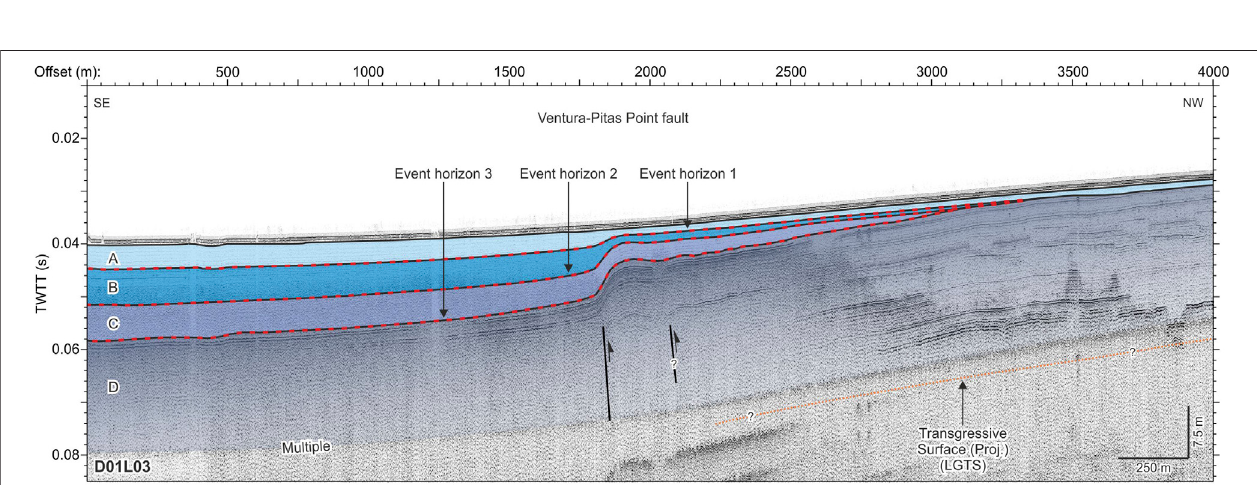
FIGURE 9 | Interpreted CHIRP pro fi le D01L03 acquired across the Pitas point thrust fault. Different seismostratigraphic units (A – D) are identi fi ed based on stratal geometries.Thered dashed linesidentifyhorizonscorrespondingtodifferentdeformationevents(i.e.,inferred earthquakes).TheLGTS(dashedorangeline) isprojected from the structural contour map as it is not well imaged as it is obscured by the multiple. The location of the pro fi le is shown in Figures 2 , 3 . Uninterpreted pro fi le is provided in Supplementary Figure S8 .